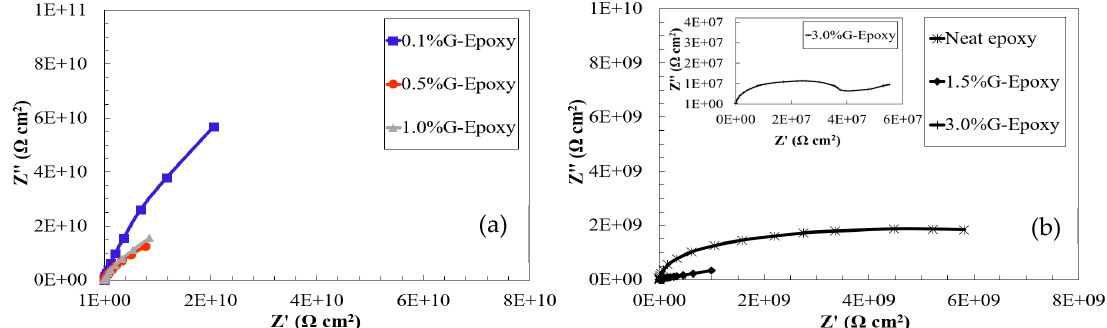
Figure 7. Nyquist plots for: ( a ) 0.1~1.0 %G-Epoxy and ( b ) 1.5~3.0 %G-Epoxy and the reference.